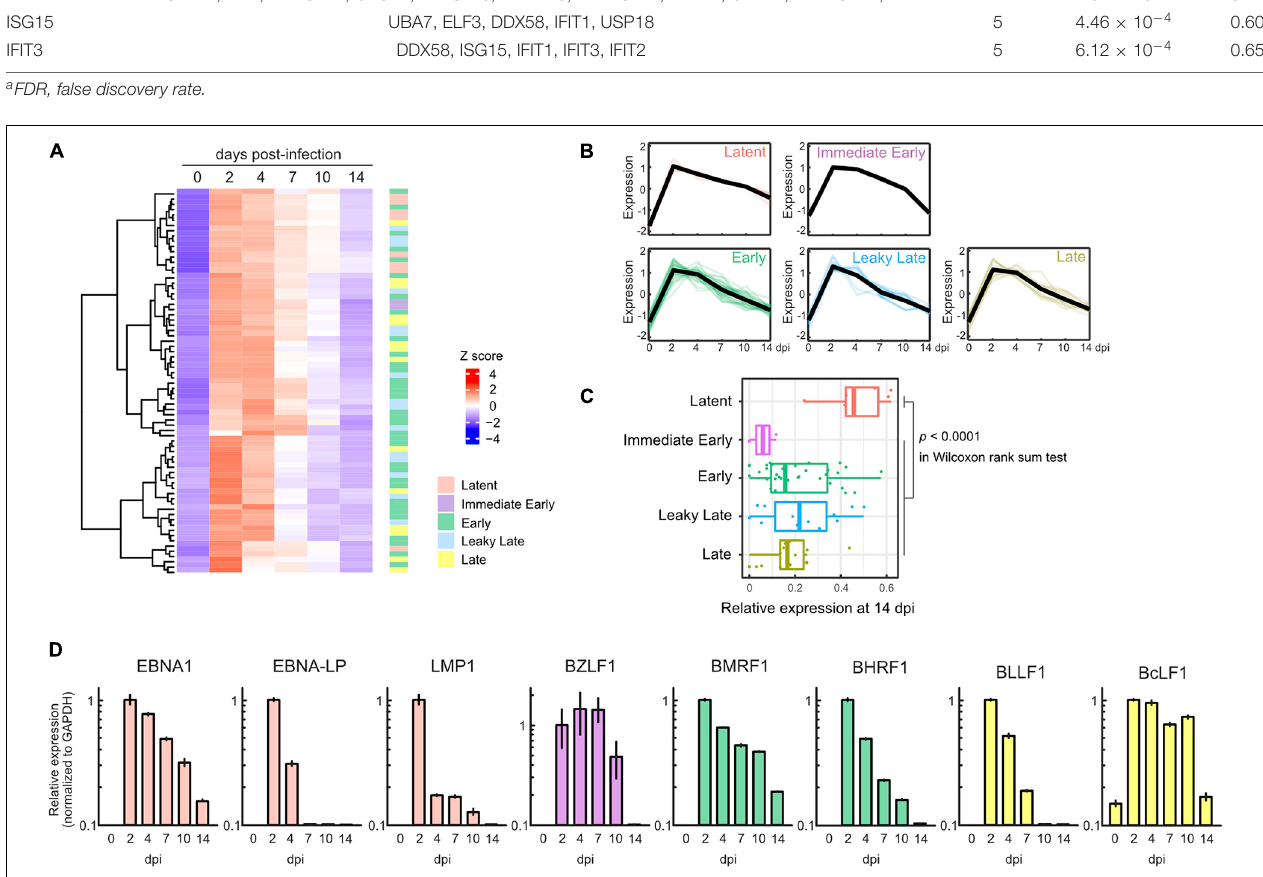
FIGURE 2 | Transient burst of viral lytic gene expression in the pre-latent phase of EBV infection of Akata(–) cells. (A) Heat map showing the viral gene expression changes during EBV infection of Akata(–) cells. (B) Temporal change of viral gene expression in each kinetic lytic gene. The changes of respective genes and the mean values (black) are plotted. Viral gene expression kinetics are categorized into five groups: latent, immediate early, early, leaky late, and late (Djavadian et al., 2018). (C) Relative viral gene expression of latent, immediate early, early, leaky late, and late kinetics at 14 dpi. (D) Validation of viral gene expression by qRT-PCR. Viral gene expression was normalized to GAPDH expression. Results are presented as means ± SD of three independent experiments and are shown relative to gene expression at 2